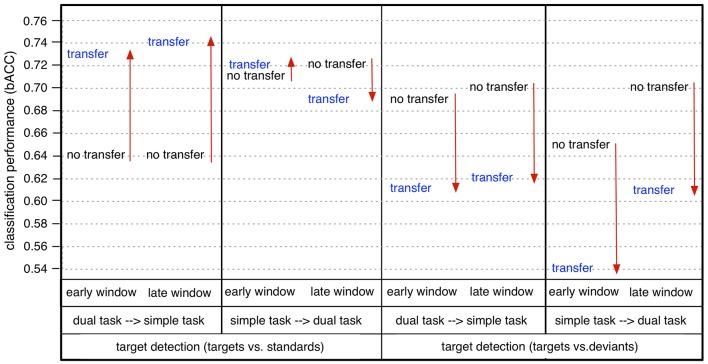
Comparison between no transfer and transfer in binary classification performance (bACC) in case of using 2 channels (CPz/Pz): dual task → simple task (transfer) vs. simple task (no transfer), simple task → dual task (transfer) vs. dual task (no transfer). Arrow direction refers to significant increases or decreases. Lines without arrow direction refer to no significant difference. Statistical values for comparison are reported in Supplementary Materials in Figure S5 (comparison between dual task → simple task (d→s) and simple task (s) and comparison of between dual task → simple task (d→s) and dual task (d) in Figure S5).